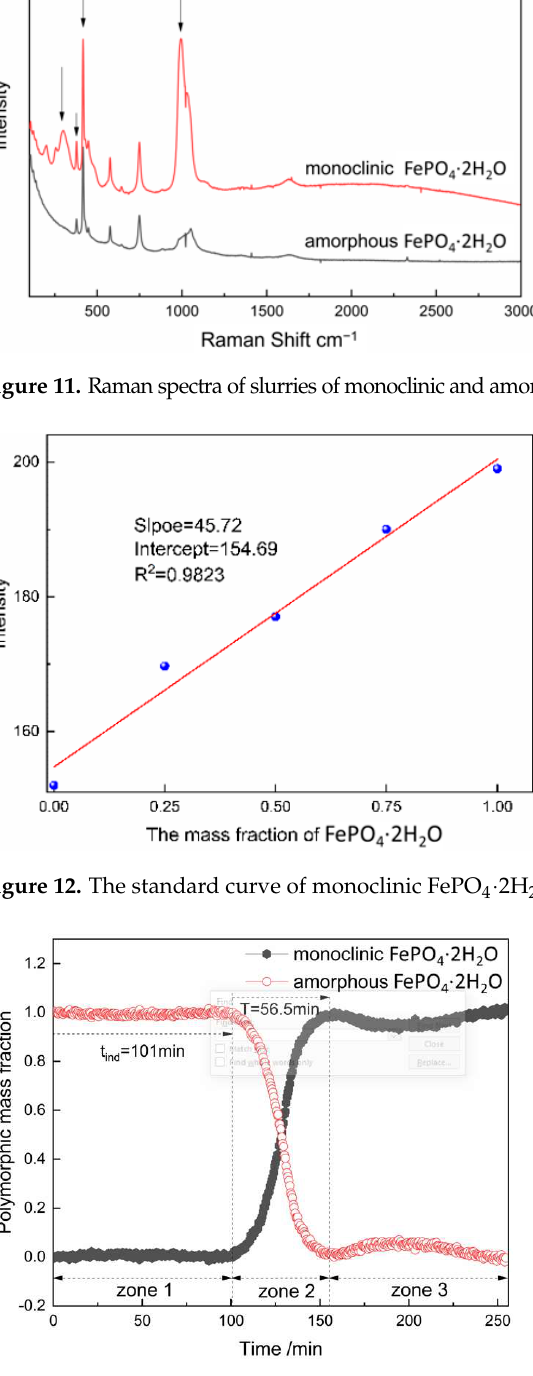
Figure 13. In situ polymorphic mass fraction profiles of monoclinic and amorphous FePO 4 ·2H 2 O through the solvent-mediated transformation process.